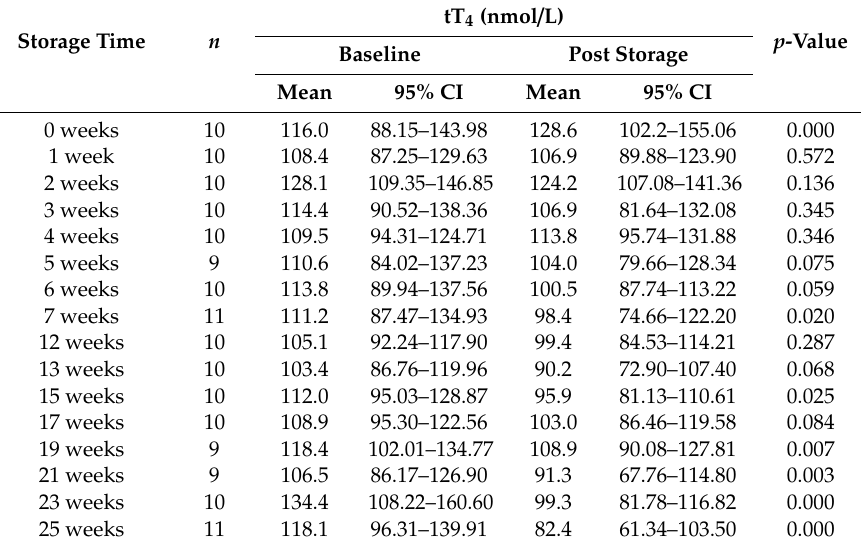
Table 1. Mean thyroxine baseline and post-storage